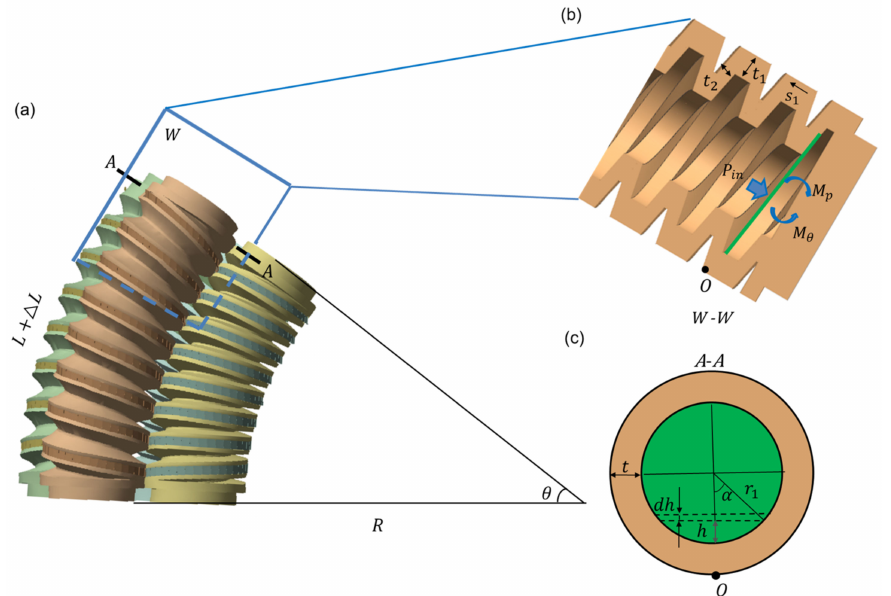
Figure 3. Bending model of the soft wrist: ( a ) bending of four actuators; ( b ) longitudinal section of a pressured actuator; ( c ) actuator chamber transverse